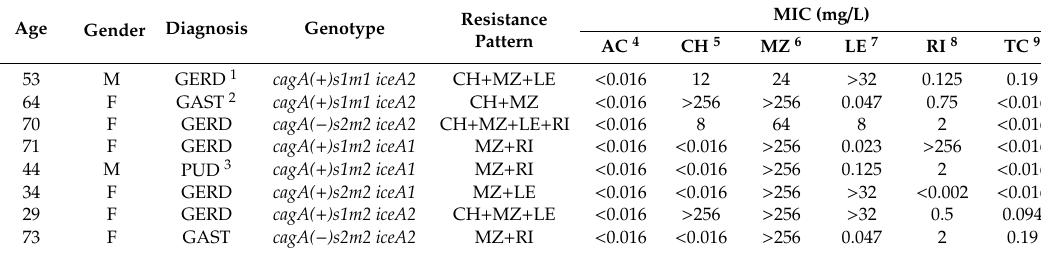
Table 5. Characteristics of multidrug resistant H. pylori